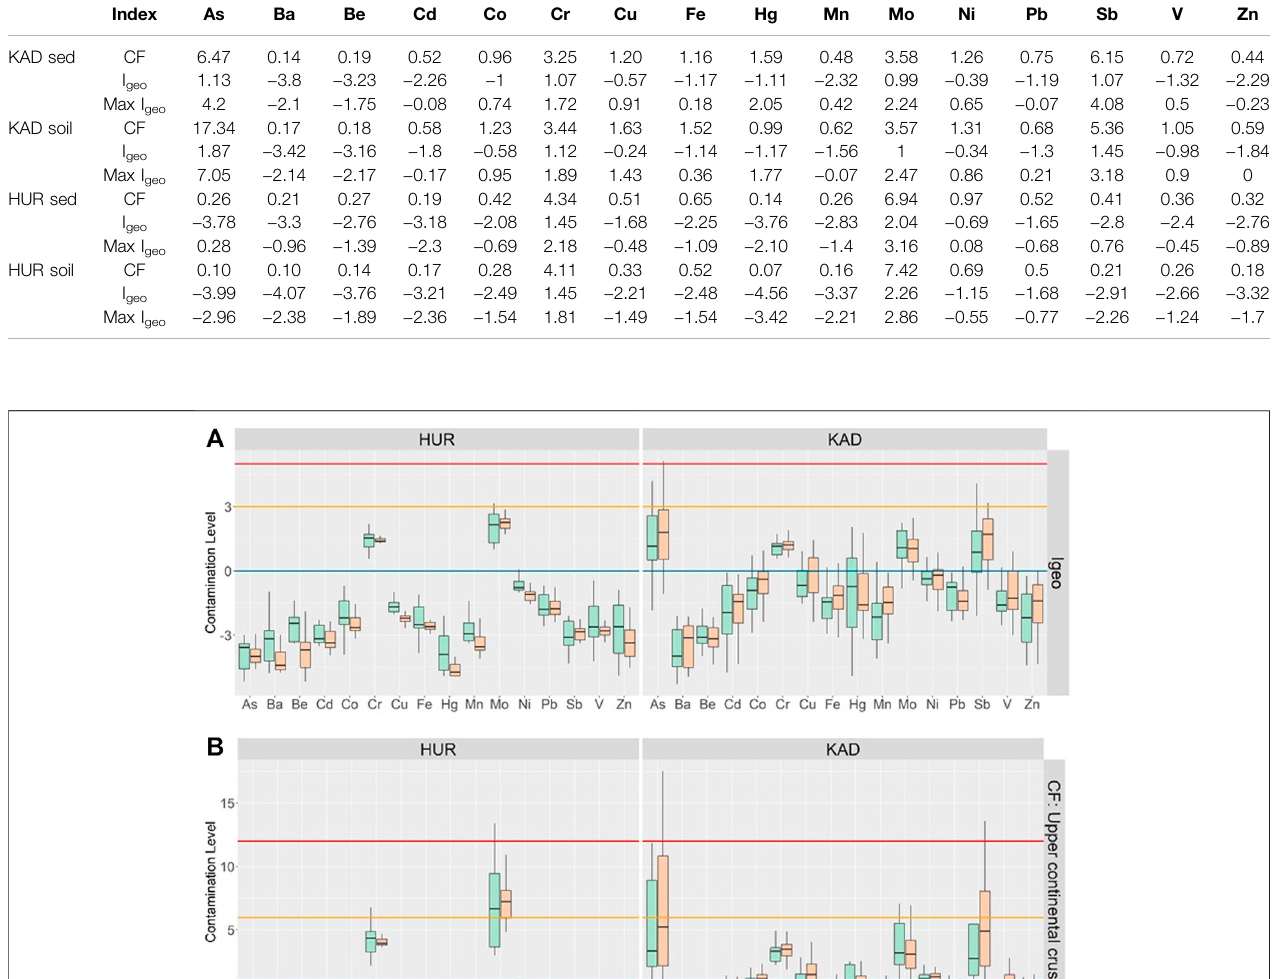
Frontiers in Environmental Science |